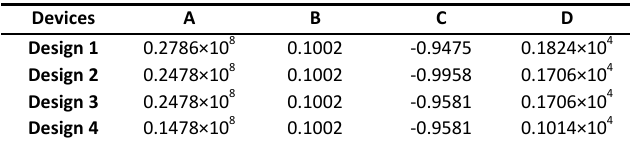
Table 2: Constant values for different designs of three- electrode devices.